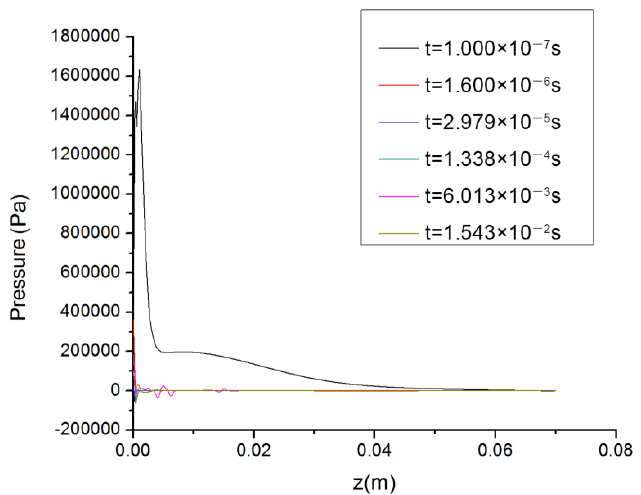
Figure 10. Variation of pressure on spinning line with time.